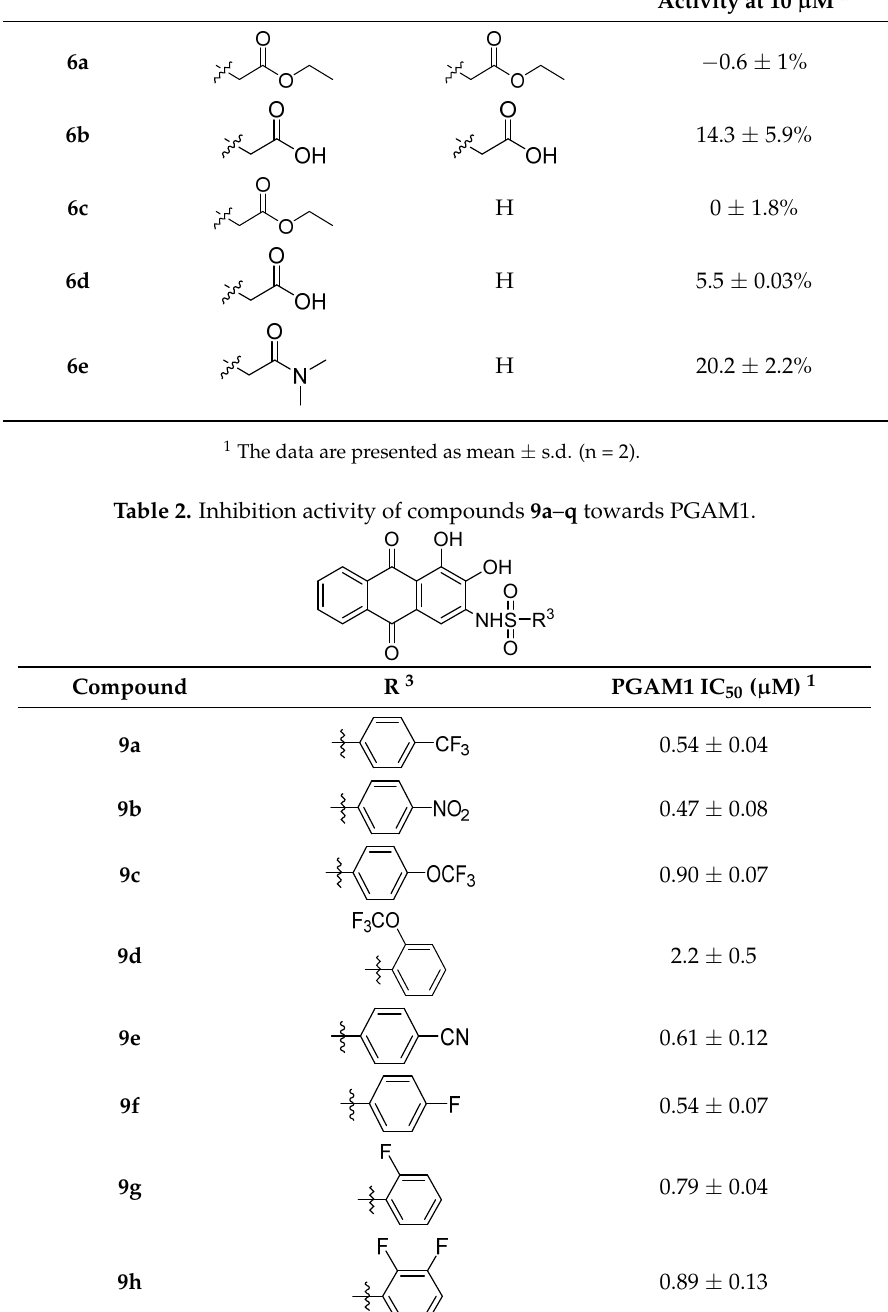
Table 1. Inhibition activity of compounds 6a – e towards PGAM1 .